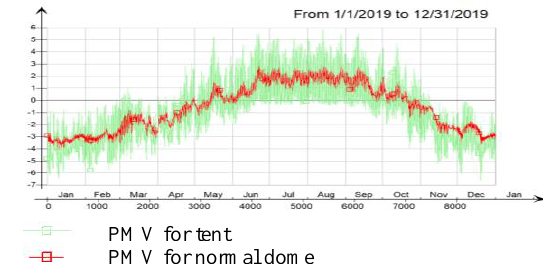
Figure 9. PMV comparison of normal dome and tent